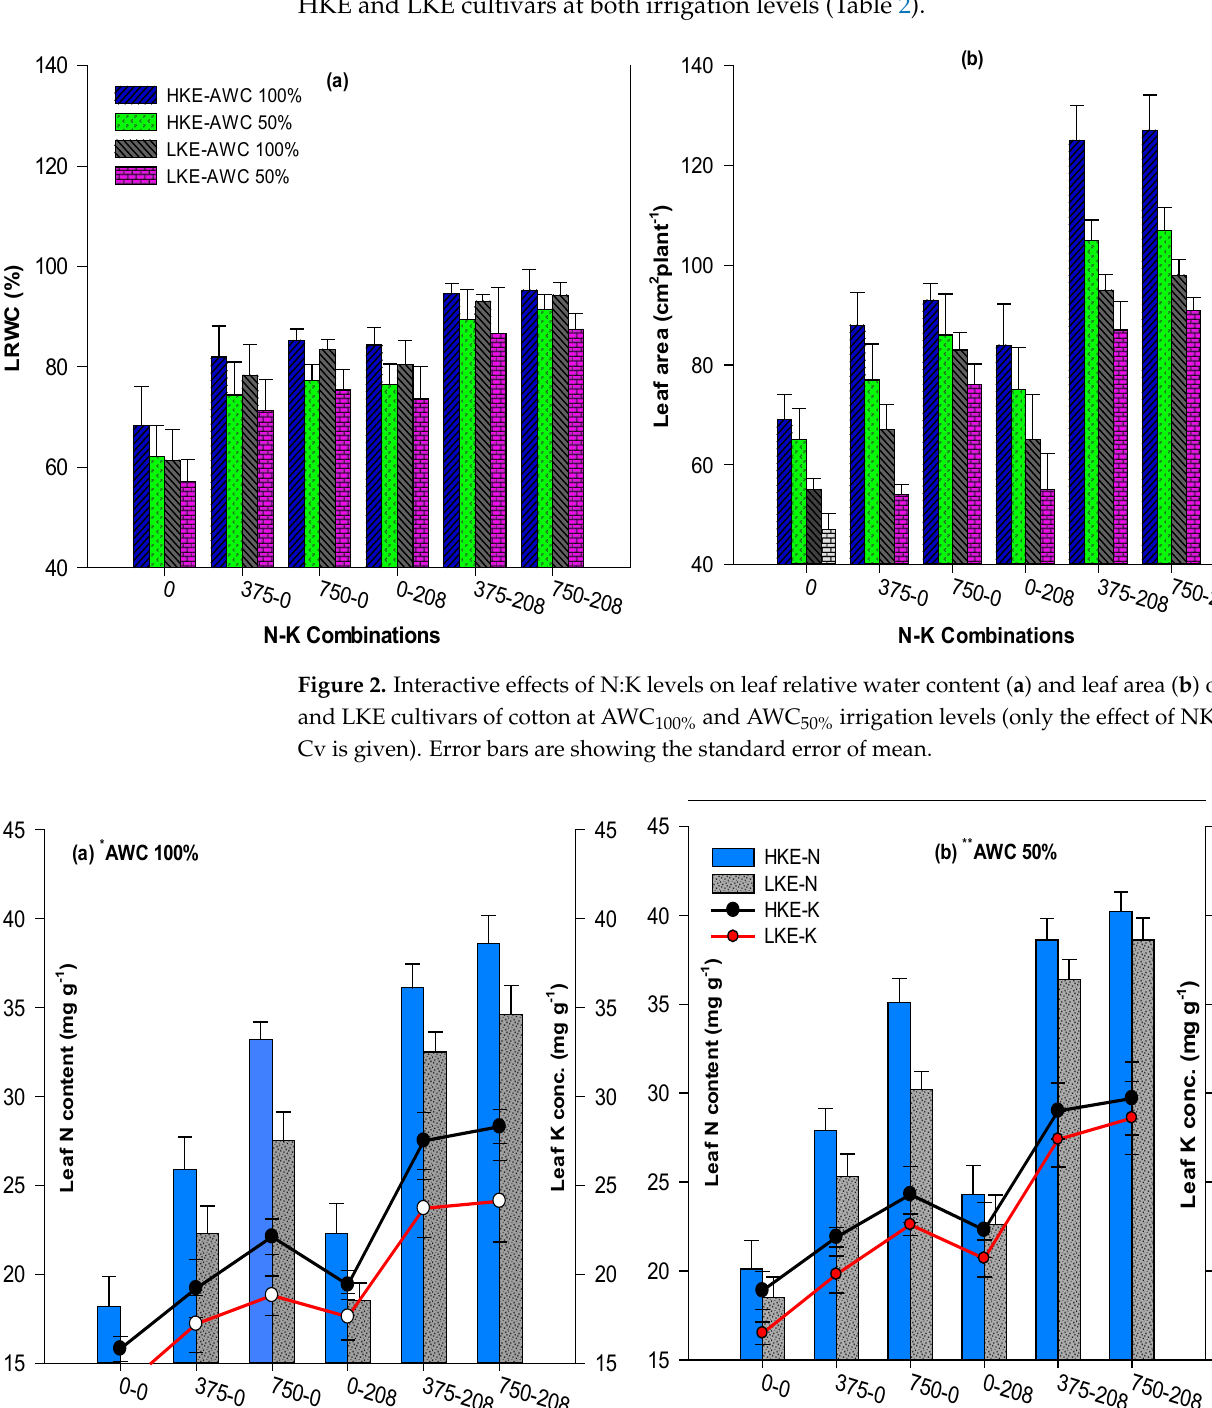
Table 2. Effects of N:K levels on N and K uptake in cotton cultivars under varied irrigation levels.